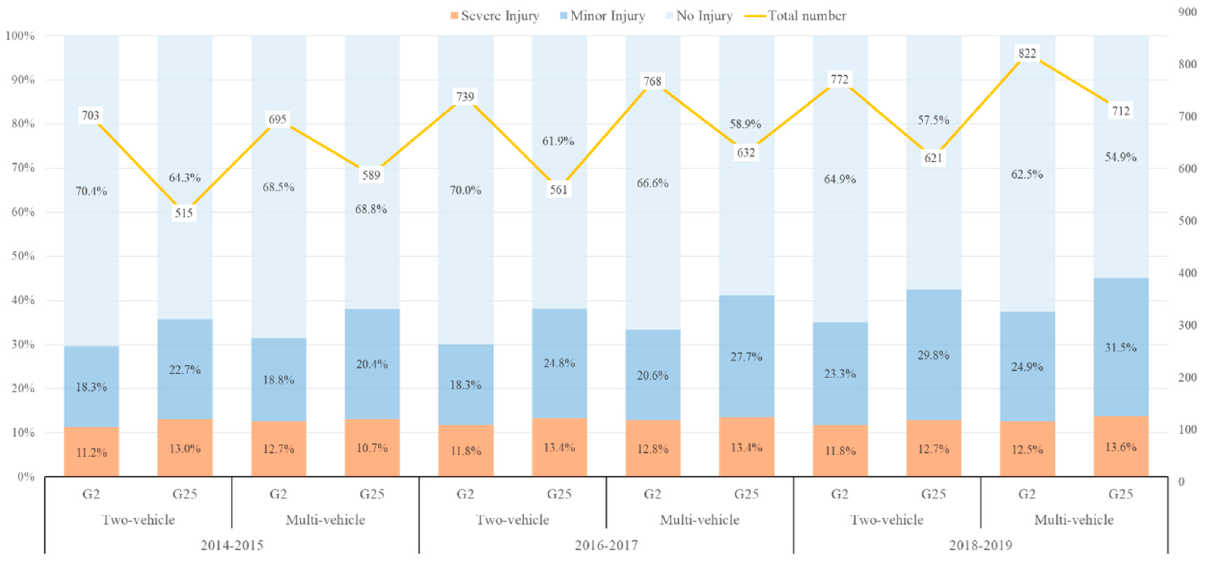
Figure 1. Two-vehicle and multi-vehicle freeway rear-end crash injury severity distribution for G2 and G25 freeways over the years: 2014–2019.